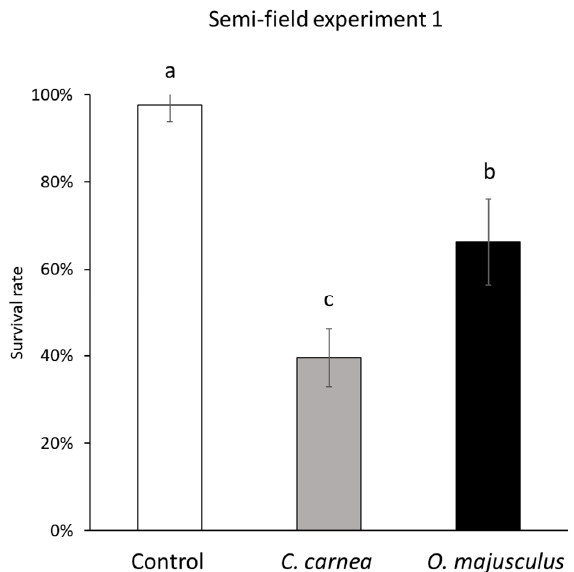
Figure 3. Survival rates (mean ± SE) of Erasmoneura vulnerata nymphs observed in the three treat- ments ( Chrysoperla carnea , Orius majusculus , and Control) under comparison in the semi-field exper- iment (1), two weeks after predator releases. In this experiment, 60 E. vulnerata nymphs per cage were introduced at the beginning of the trial. Predators were released in a ratio of 1/10 E. vulnerata nymphs ( C. carnea ) or 1/30 E. vulnerata nymphs ( O. majusculus ). Different letters indicate significant differences in the Tukey’s test ( p = 0.05).